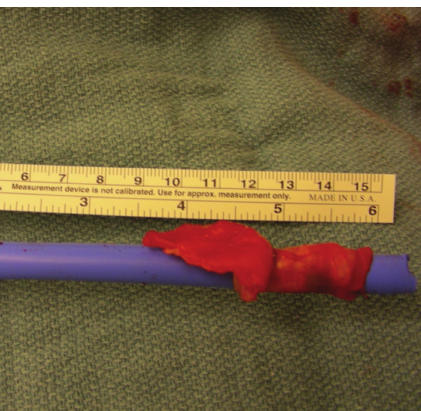
Figure 2: Photograph of a portion of the iliac artery that was withdrawn with the sheath, otherwise known as